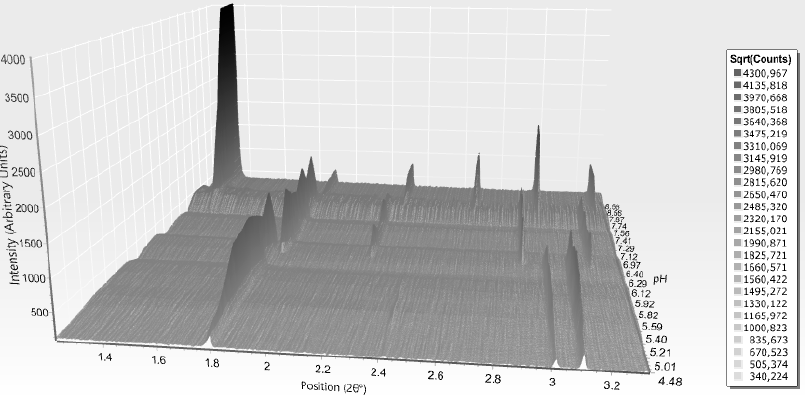
Figure 13. Surface plot illustrating the evolution of diffraction patterns from HI polycrystalline samples in the absence of ligands, at low 2 θ range, while varying the pH (5.00–8.60). Patterns were collected at ESRF (ID22, λ = 1.29974(6) Å, 280 K) [90]. resolution of 3.3 Å ( R 3 polymorphs) and 2.7 Å ( I 2 1 3 polymorph) as illustrated in Figure 14.